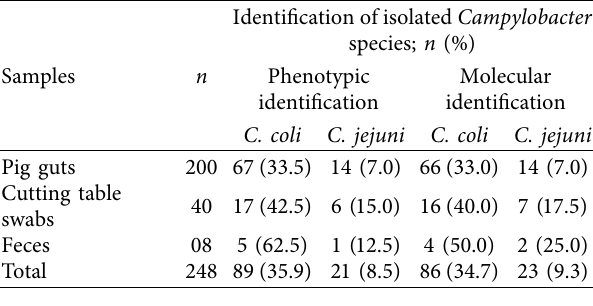
Table 3: Phenotypic and molecular identification of isolated Campylobacter species.